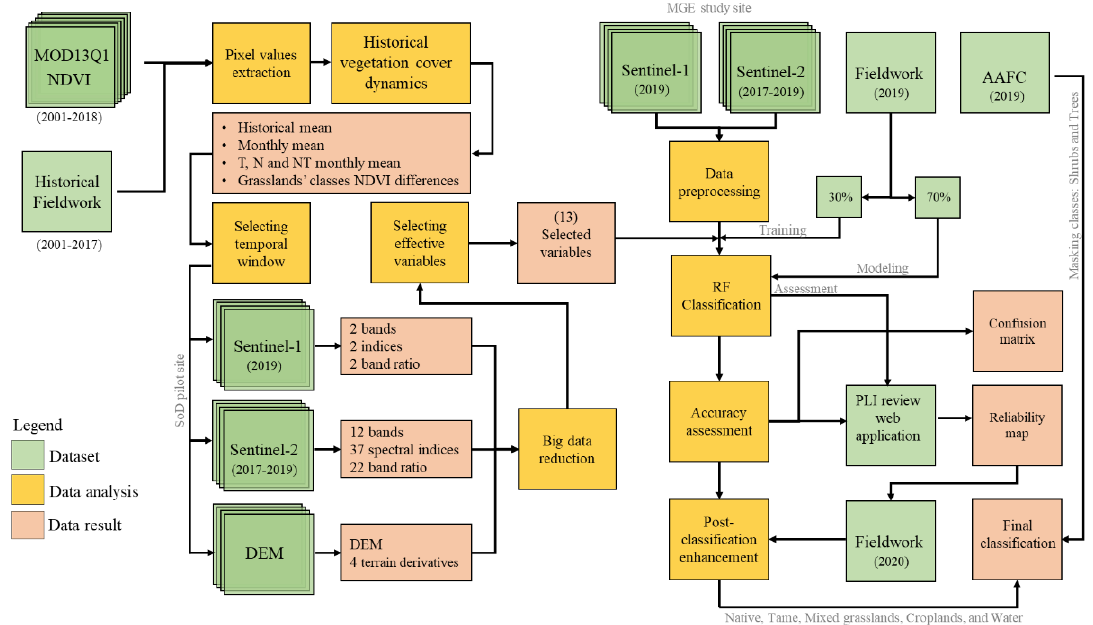
Figure 3. The overall workflow of MGE mapping procedures using various remote sensing datasets and platforms to produce PLI MGE classification for 2019.